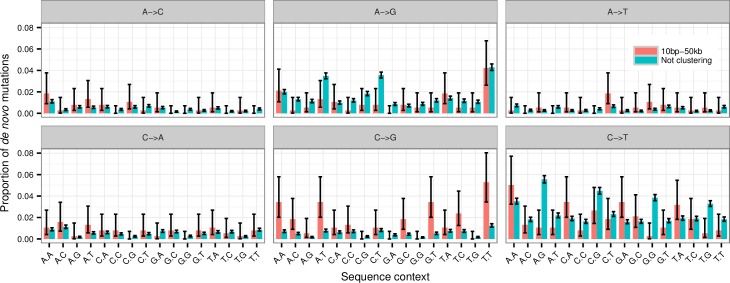
Distribution of mutation types with sequence context.The relative distribution of different types of mutation when the bases immediately 5’ and 3’ to the mutated base is included. Stratified based on whether the mutation clustered 10bp-20kb from another mutation or was not part of a cluster. The error bars are 95% confidence intervals.